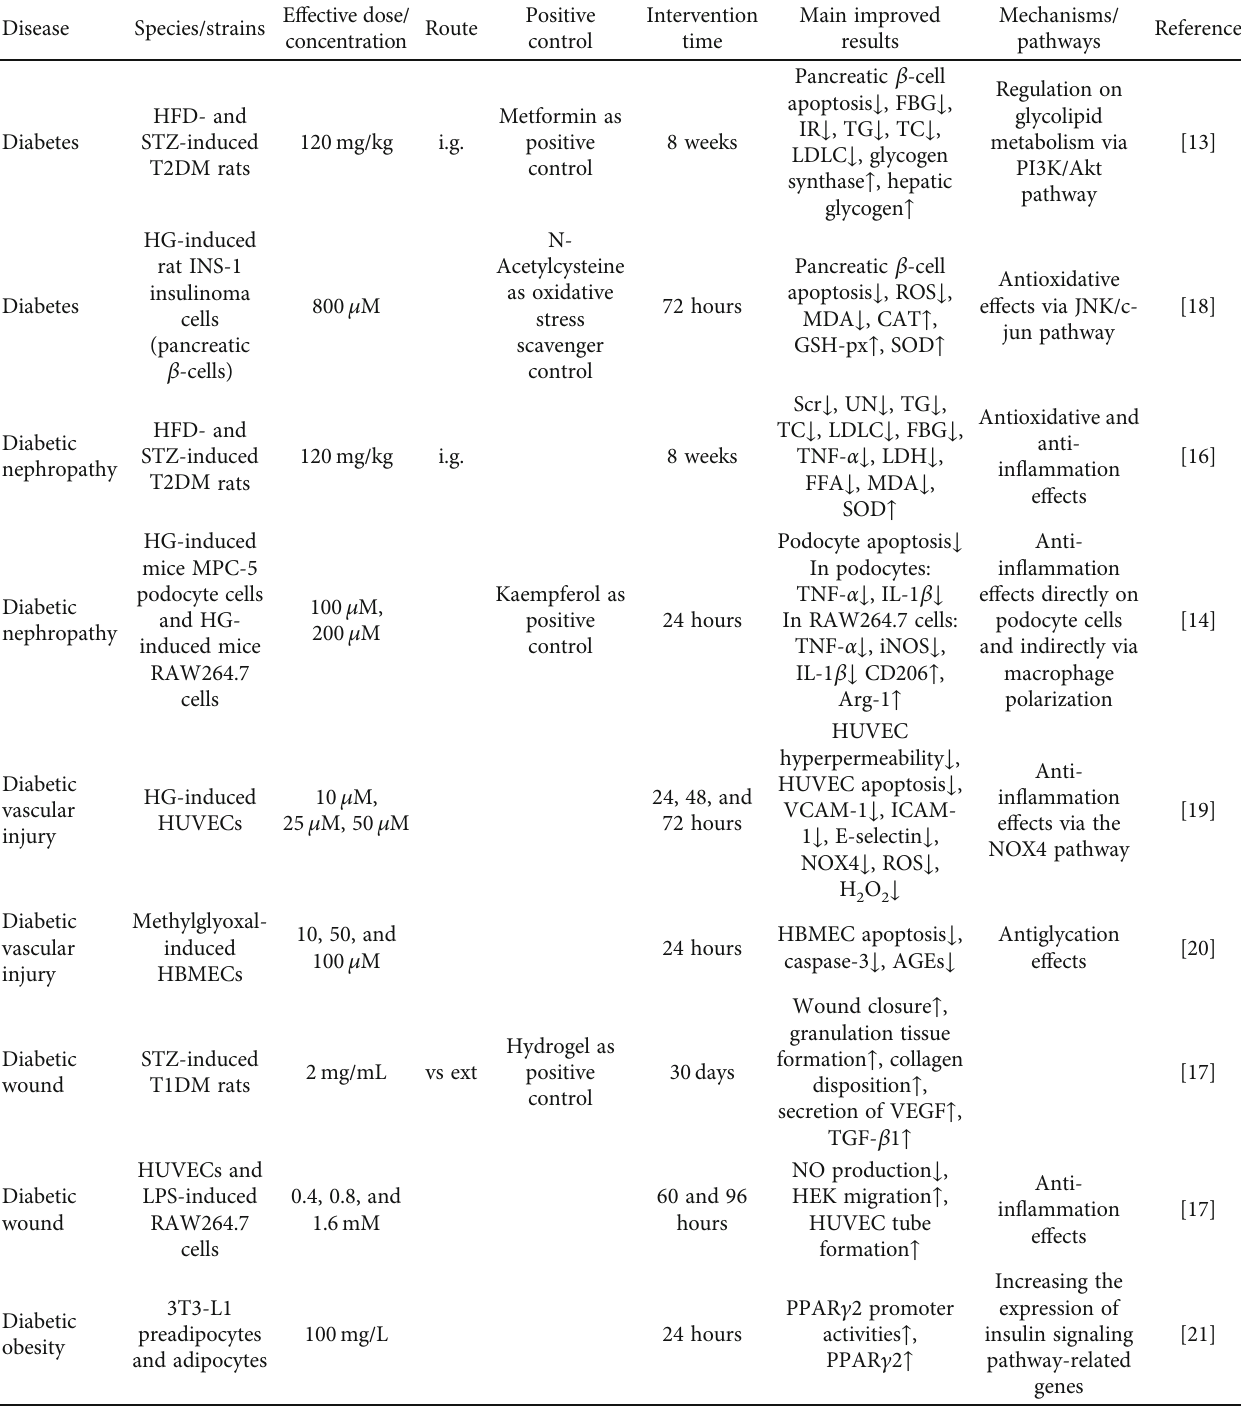
Table 1: Summary of pharmacological e ff ects and mechanisms of HSYA on diabetes and diabetes complications. E ff ective dose/ Disease Species/strains concentration